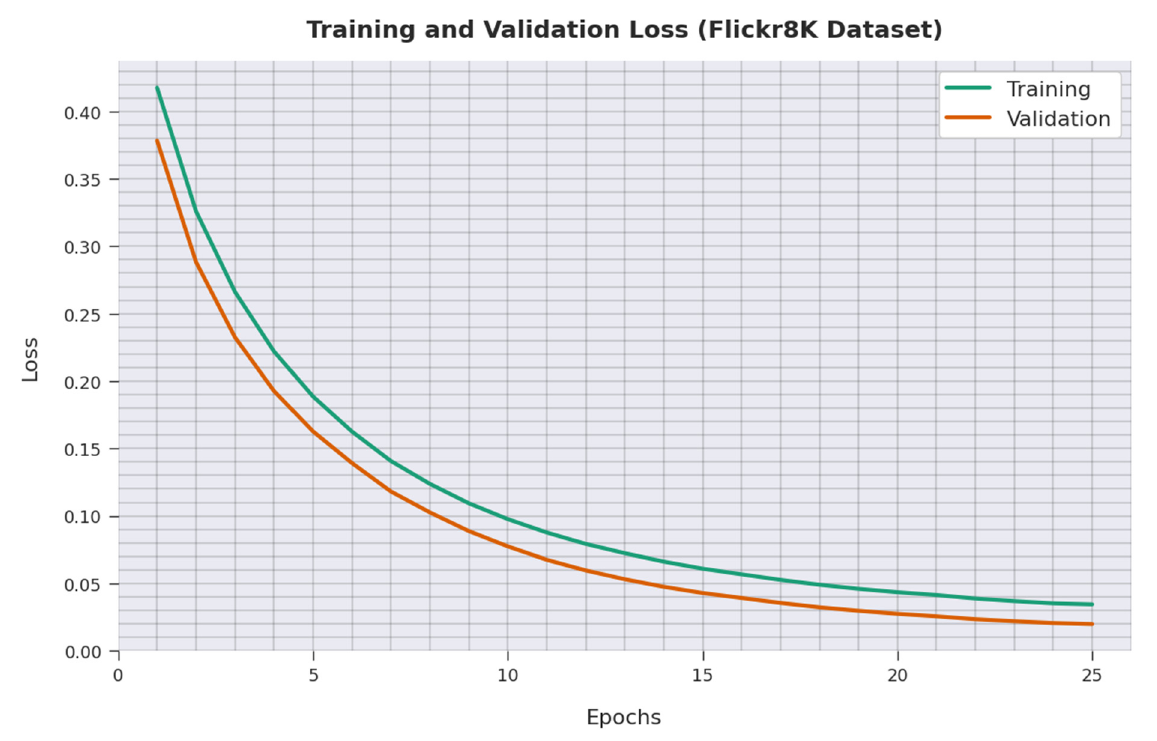
Figure 6. TA and VA analysis of MODLE-AICT technique on Flickr8K dataset.